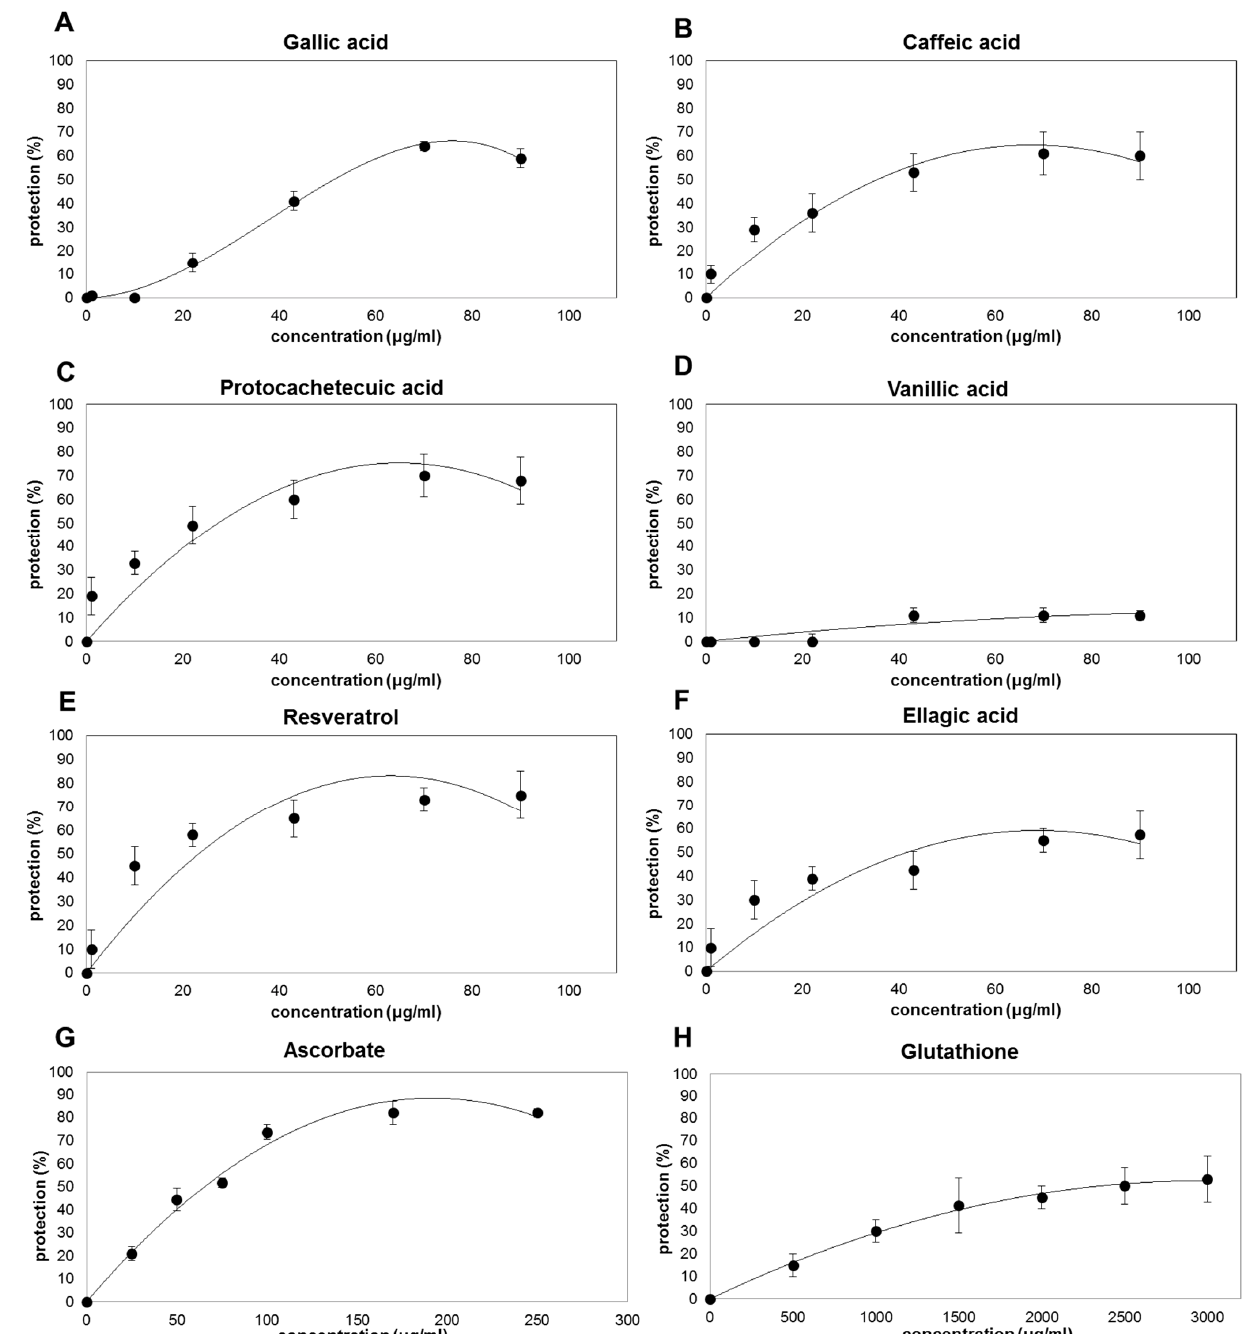
Figure 3 . Protective effect of purified standard molecules on RBC membrane oxidation by UV-B radiation. The protective effects of different antioxidant standard molecules (Gallic Acid (A); Caffeic Acid (B); Protocachetecuic Acid (C); Vanillic Acid (D); Resveratrol (E); Ellagic Acid (F); Ascorbate (G); Glutathione (H)) are expressed as percentage inhibition of MDA formation induced by UV irradiation in the RBC membranes pre-incubation with different concentrations of the antioxidants in comparison with the MDA produced by the same RBC membrane in absence of the same antioxidant mixes or purified molecules. The concentration of the antioxidants was increased until reaching a plateau indicating that saturation in the protective efficiency has been reached. The values are the means of three independent experiments ±